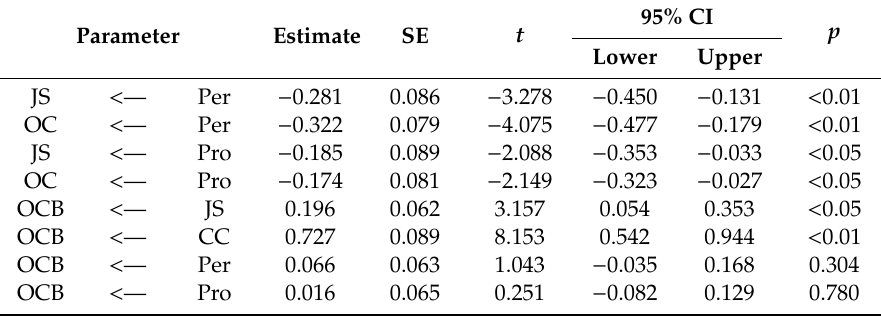
Table 3. Results of 5000 rounds of bootstrapping